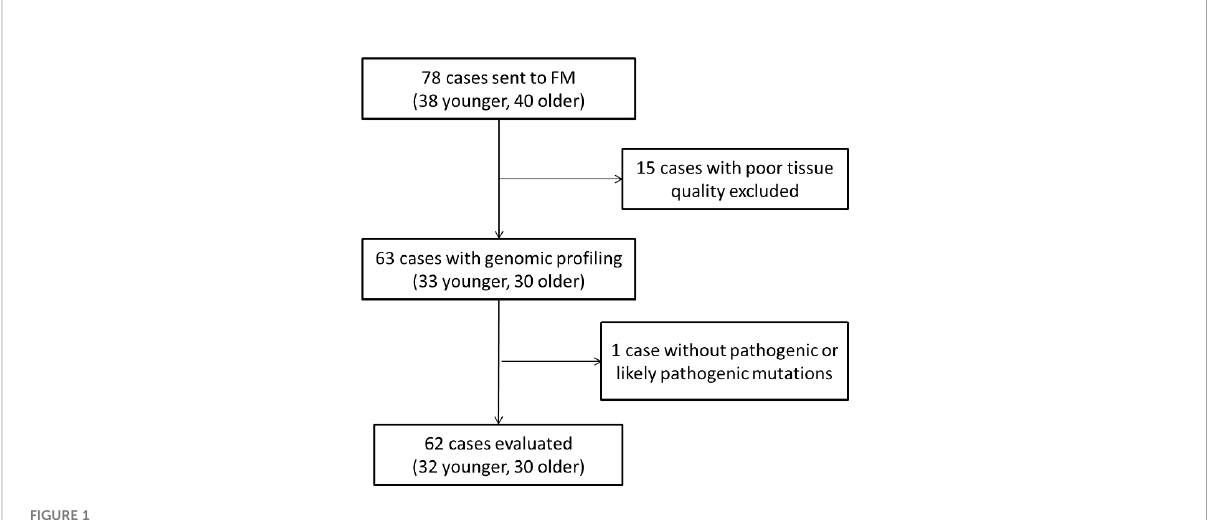
FIGURE 1 Flowchart of the patient included in the study. FM, Foundation